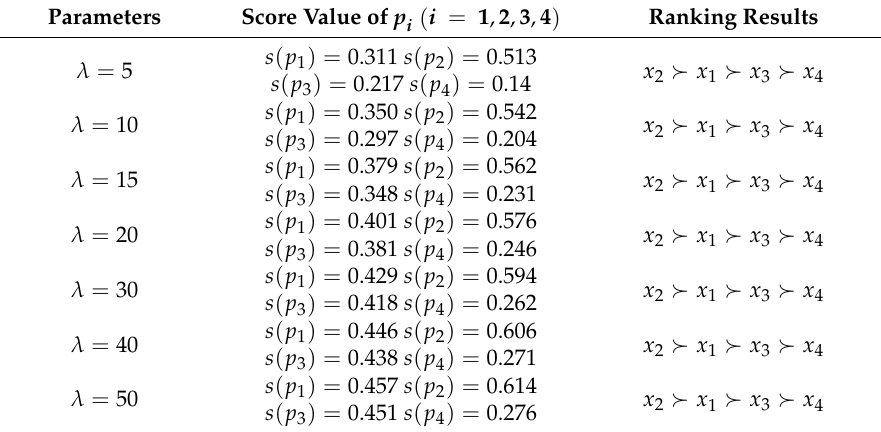
Table 3. Rankings with different value of